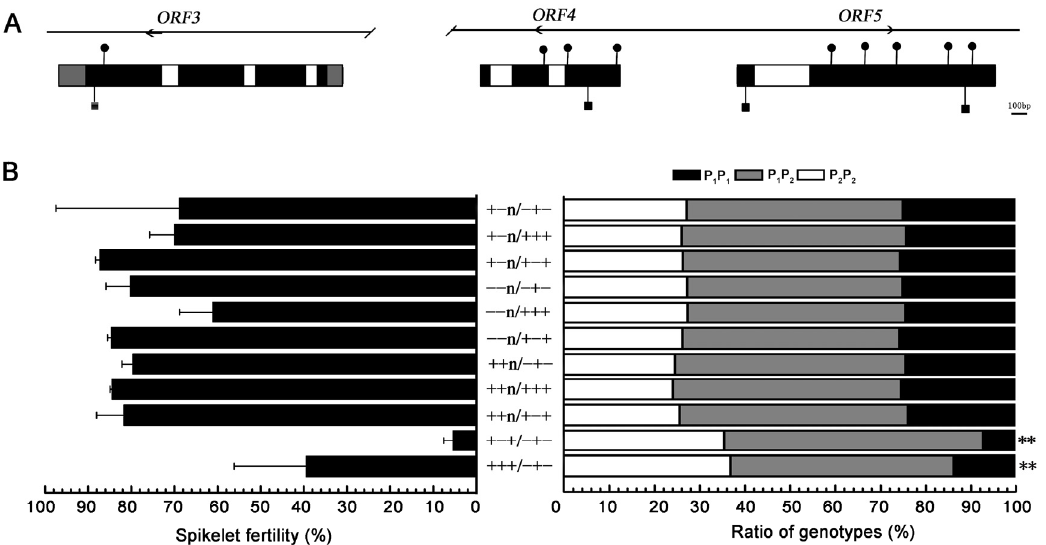
Figure 1. Genetic effect of ORF3 , ORF4 , and ORF5 at the S5 locus in different indica/japonica crosses. ( A ) Schematic drawing of polymorphisms in CDS of three genes at S5 locus. Black boxes and white boxes represent the exons and introns respectively. Single nucleotide polymorphisms are indicated by lines with solid circles in the gene model. Insertions/deletions (InDels) are indicated by lines with a solid block in the gene model. ( B ) Spikelet fertility of F 1 hybrids in different genotypes at the S5 locus (left) and the ratio of genotypes at the S5 locus in the F 2 populations from different indica / japonica crosses (right). + − n/ − + − , + − n/+++, + − n/+ − +, −− n/ − + − , −− n/+++, −− n/+ − +, ++n/ − + − , ++n/+++, ++n/+ − +, + − +/ − + − , and +++/ − + − represented the hybrid F 1 in the genotype of ORF3 +/ ORF4 − / ORF5 n/ ORF3 − / ORF4 +/ ORF5 − , ORF3 +/ ORF4 − / ORF5 n/ ORF3 +/ ORF4 +/ ORF5 +, ORF3 +/ ORF4 − / ORF5 n/ ORF3 +/ ORF4 − / ORF5 +, ORF3 − / ORF4 − / ORF5 n/ ORF3 − / ORF4 +/ ORF5 − , ORF3 − / ORF4 − / ORF5 n/ ORF3 +/ ORF4 +/ ORF5 +, ORF3 − / ORF4 − / ORF5 n/ ORF3 +/ ORF4 − / ORF5 +, ORF3 +/ ORF4 +/ ORF5 n/ ORF3 − / ORF4 +/ ORF5 − , ORF3 +/ ORF4 +/ ORF5 n/ ORF3 +/ ORF4 +/ ORF5 +, ORF3 +/ ORF4 +/ ORF5 n/ ORF3 +/ ORF4 − / ORF5 +, ORF3 +/ ORF4 − / ORF5 +/ ORF3 − / ORF4 +/ ORF5 − , and ORF3 +/ ORF4 +/ ORF5 +/ ORF3 − / ORF4 +/ ORF5 − respectively. P 1 P 1 , Genotype of S5 in female parents. P 1 P 2 , Heterozygous genotype. P 2 P 2 , Genotype of S5 in male parents. Error bars represent SD, n = 10. ** Significantly different at 0.01 probability level.